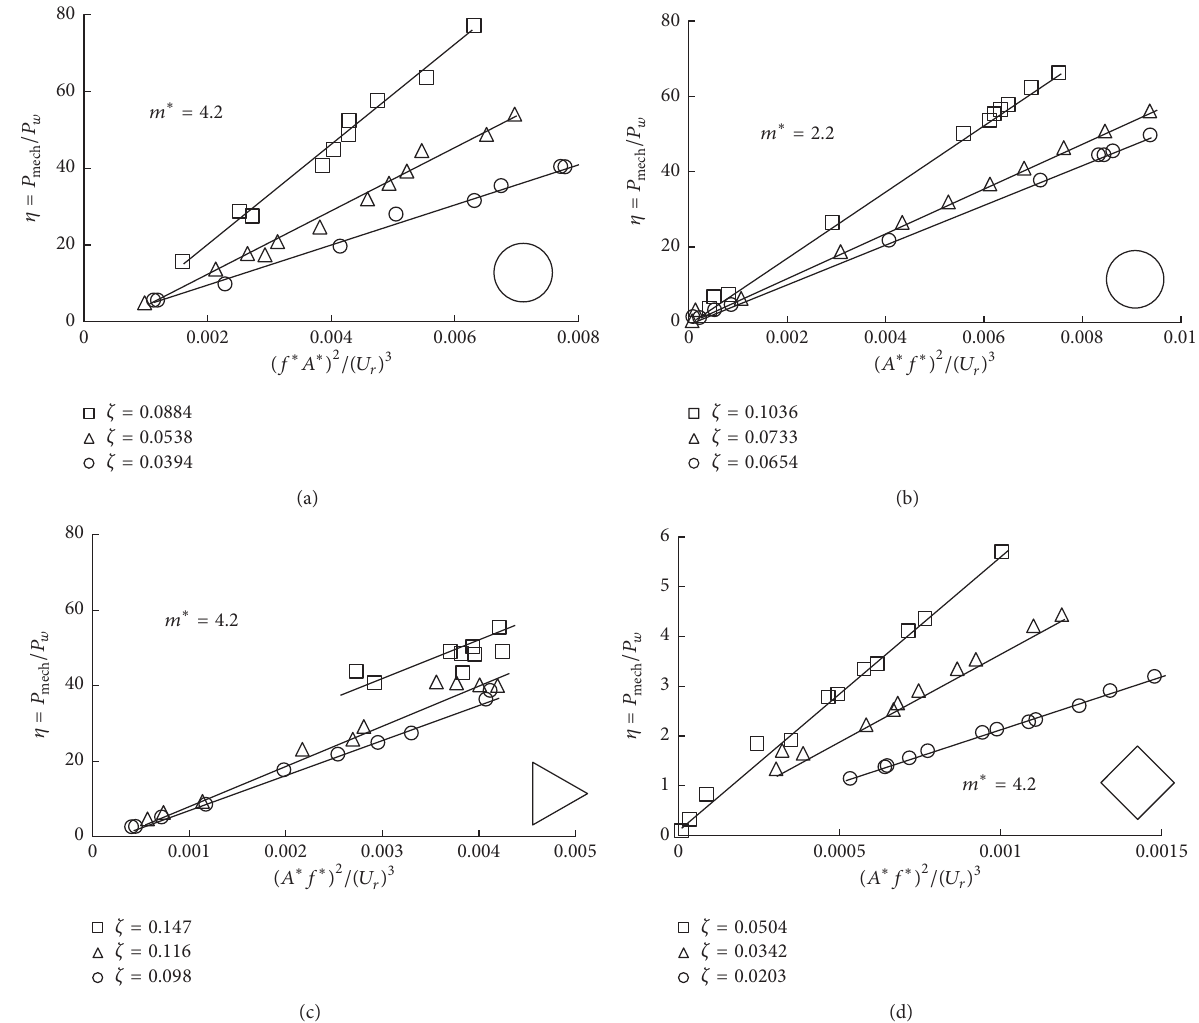
Figure 12: Variations of the transfer ratios 𝜂 against the combined parameters (𝐴 ∗ 𝑓 ∗ ) 2 /(𝑈 𝑟 ) 3 . (a) Circular cylinders, 𝑚 ∗ = 2.2 ; (b) circular cylinders, 𝑚 ∗ = 4.2 ; (c) regular triangle prisms, 𝑚 ∗ = 4.2 ; (d) diamond prisms; 𝑚 ∗ = 4.2 .